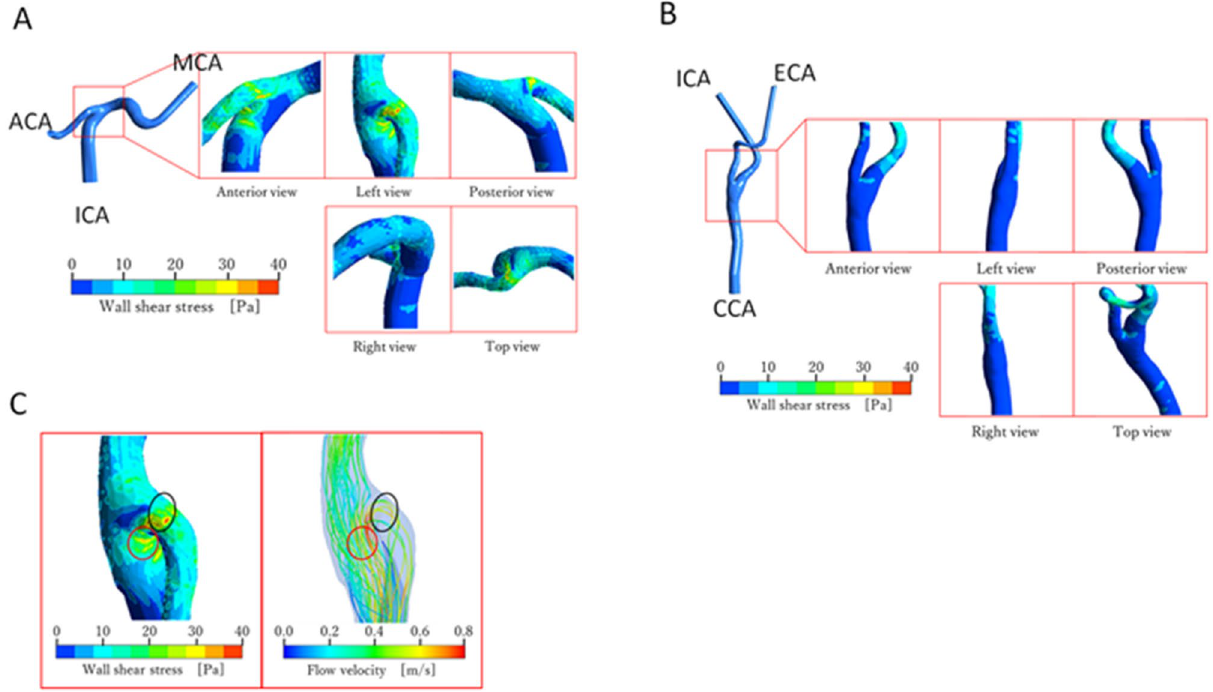
Figure 7. ( A ) WSS distribution around the ICA terminal (model A). ACA, anterior cerebral artery; MCA, middle cerebral artery. ( B ) WSS distribution around the CCA terminal (model B). ECA, external carotid artery. ( C ) Comparison of the WSS distribution with stream lines near the ICA terminal bifurcation (model